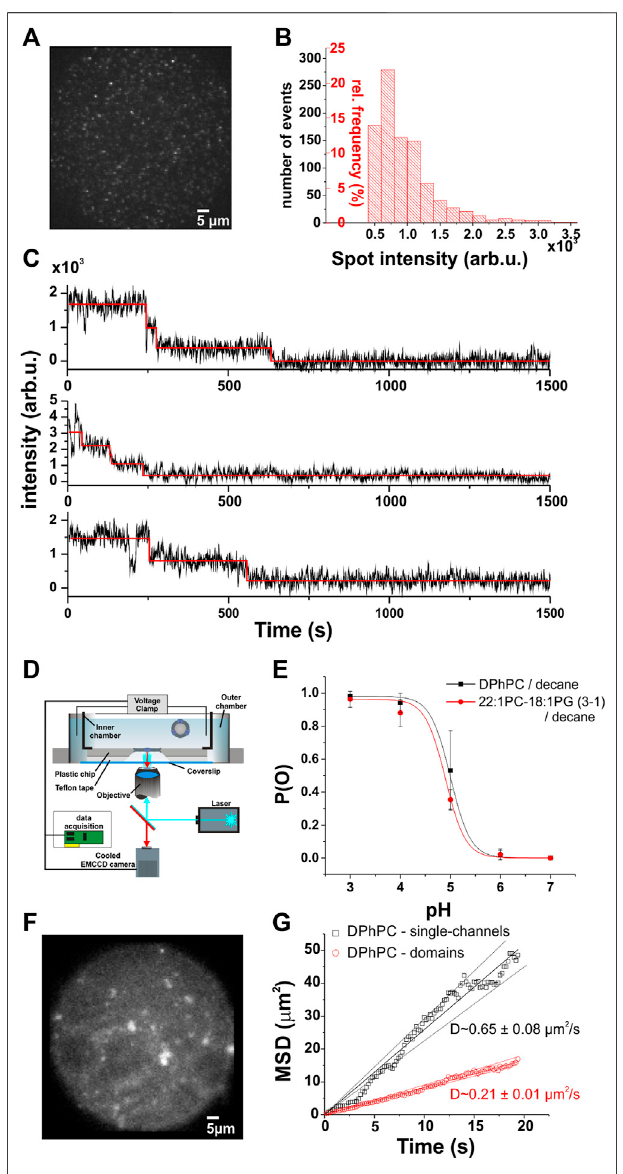
FIGURE 1 | Single-channel voltage-clamp fl uorescence imaging. (A) , Single KcsA-E71A-H124C channels in DPhPC supported bilayers. (B) , The normalized frequency distribution of spot intensities shows a single-channel fl uorescencepeakrangingfrom~500 – 3,500arb.u.Spotswereselected only if they showed 1 – 4 photobleaching steps, as detected by automated analysis software (McGuire et al., 2012). (C) , Examples of photobleaching traces from (A) . Photobleaching experiments were performed at higher light intensity,andstepwisebleachinganalyzedwiththePIFsoftware.Byanalyzing